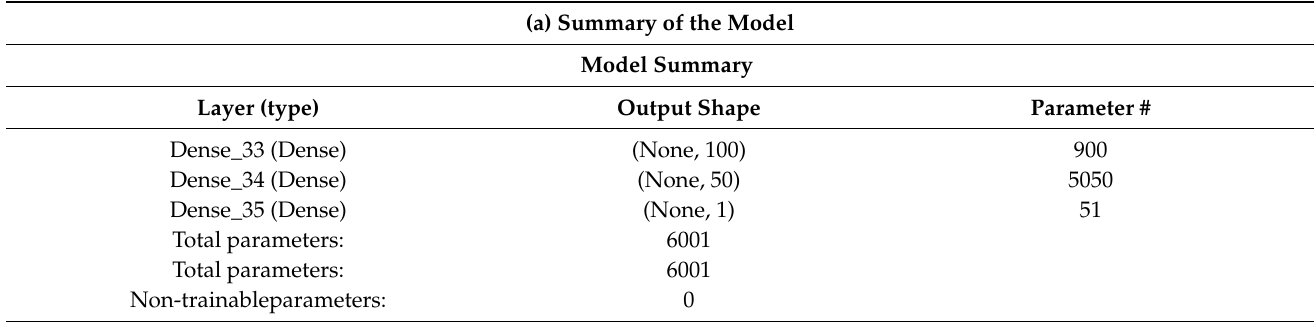
Table 2. Prediction result at model formation.